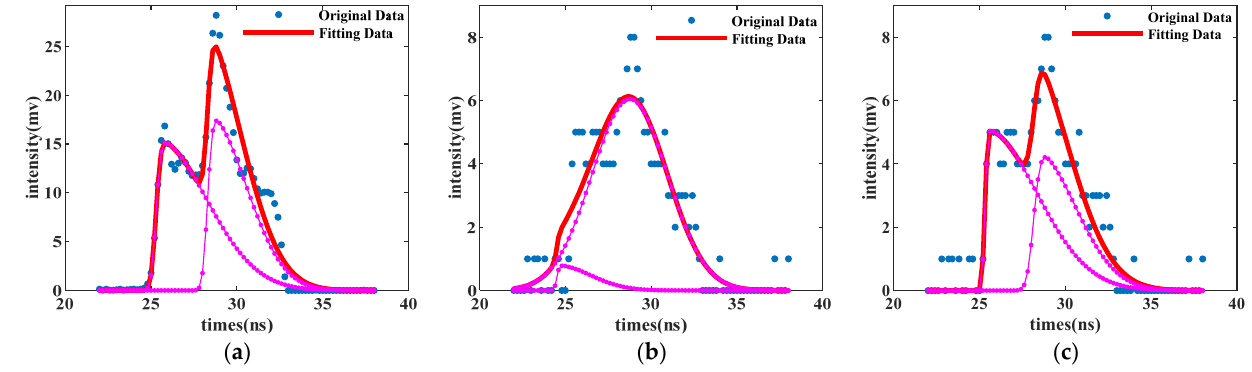
Figure 9. Comparison of waveform accumulation method and proposed method: ( a ) accumulated waveform; ( b ) 930 nm waveform by SCWD; ( c ) 930 nm waveform by MCMCD.